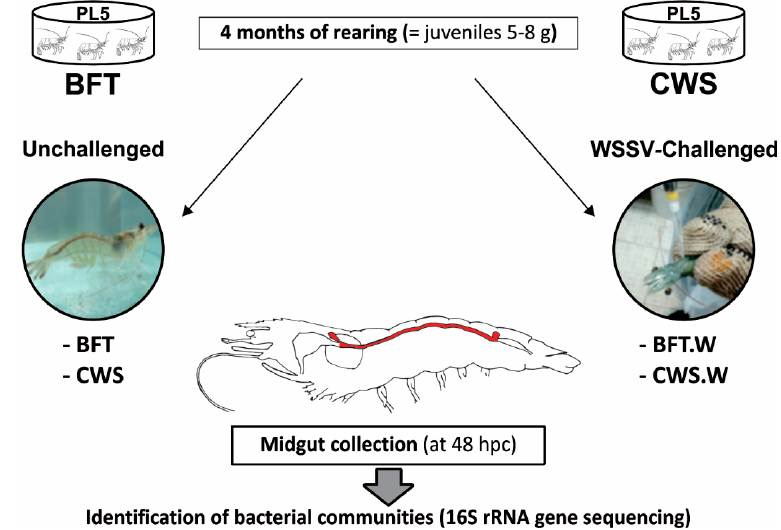
Figure 1. Post-larvae stage 5 (PL 5 = five-day-old) from lineage HB12 of Litopenaeus vannamei were cultivated during four months in two culture systems: Biofloc Technology (BFT) (4 tanks) and clear seawater system (CWS) (4 tanks), at an initial stocking density of 300 and 20 PL 5 .m − 3 , respectively. White spot syndrome virus (WSSV)-free juvenile shrimp (5–8 g) from each condition ( n = 80) were individually challenged with WSSV by the oral route (5 × 10 6 genome viral copies). The remaining animals ( n = 40/condition) were not handled. At 48 h post-challenge (hpc), midguts from unchallenged (BFT and CWS) and WSSV-challenged (BFT.W and CWS.W) shrimp ( n = 40/condition) were collected and processed for 16S RNA gene sequencing.